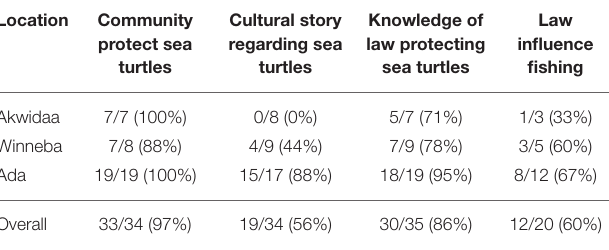
TABLE 5 | Frequency of respondents affirming community protection, a taboo, and knowledge of laws that protect sea turtles from harm in Ghana. Location Community protect sea